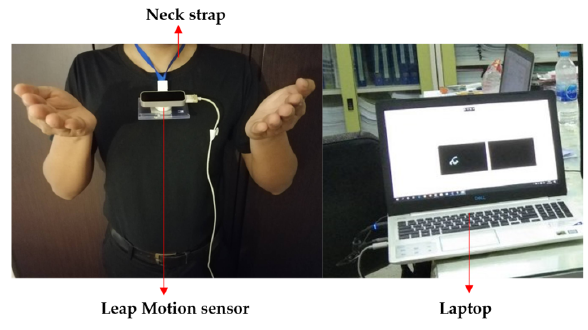
Figure 13. Photograph of the experimental setup.